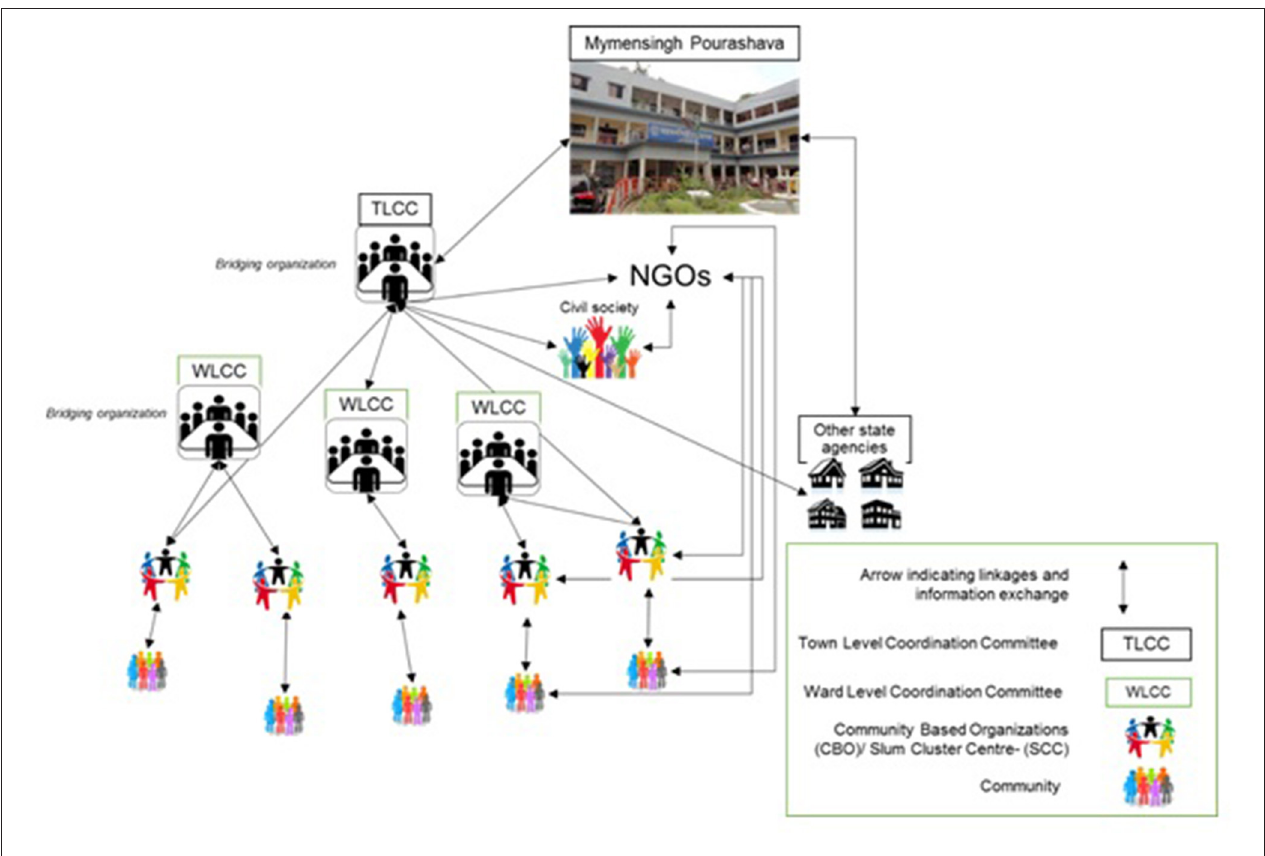
FIGURE 4 | Schematic showing networks of actors and actor clusters (town level coordination committee-TLCC and ward level town level coordination committee-WLCC) and their scales in Mymensingh city development initiatives. These actors clusters are project based (i.e., come together to deliver a specific project usually funded via an external international stakeholder), however as found through this research they play a critical role in forming a hybrid governance structure and in influencing water management decision-making. Further details on their respective roles, responsibilities and approaches are presented in Table 2